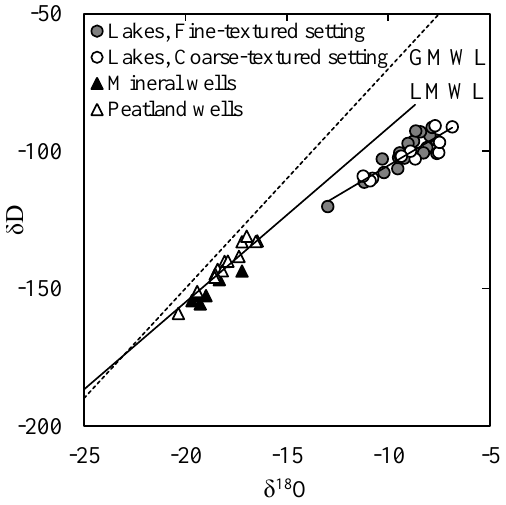
Fig. 6. Isotopic signatures of mineral soil groundwater, peatland groundwater and lake samples. Shown are also the global meteoric water line (GMWL, dashed), the local meteoric water line (LMWL) and a linear fit for all lake samples ( R 2 = 0.78, n = 30, p < 0.001).